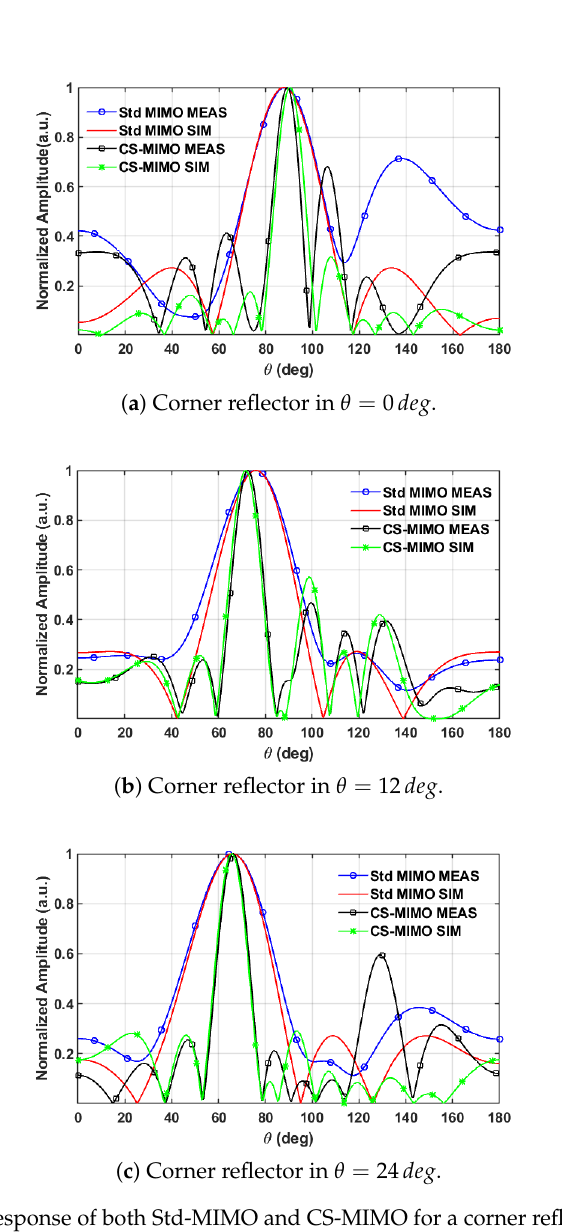
Figure 6. Azimuthal response of both Std-MIMO and CS-MIMO for a corner reflector placed at 3.25 m, with different antenna-target relative orientations.